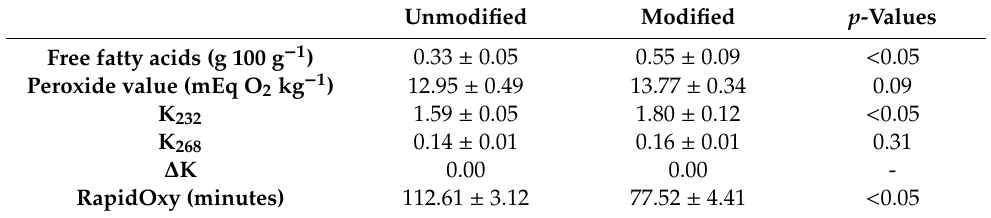
Quality features of the virgin olive oil produced by the unmodified and modified malaxer